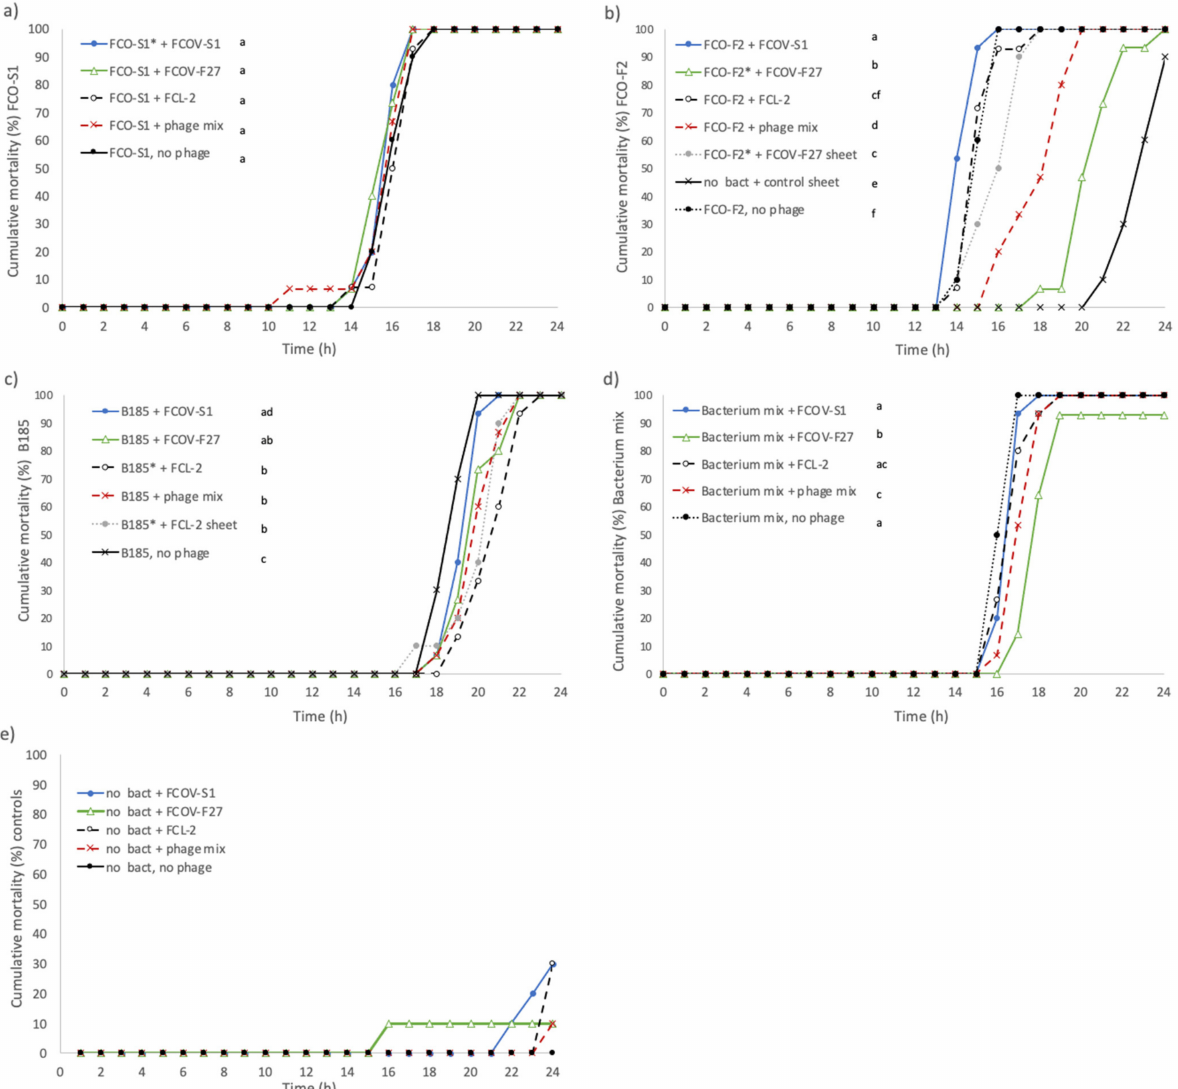
Figure 1. Experiment I: Cumulative mortalities (%) of rainbow trout fry infected with Flavobacterium columnare isolates their mix and plastic sheets coated with FCOV-F27 and FCL-2. Mortality related to control treatments without bacterial infections are presented in panel ( e ), except for the plastic control sheet (no phage coating) presented in panel ( b ). The bacterial host of the phage is indicated by an asterisk in each panel. Different lower-case letters a-f indicate statistical difference ( p < 0.05, Kaplan–Meier survival analysis, log rank pairwise comparisons, Mantel–Cox) between the treatment groups ( n = 15 rainbow trout in treatments receiving both phage and bacteria, and 10 fish in sheet and control treatments, total n of fish =